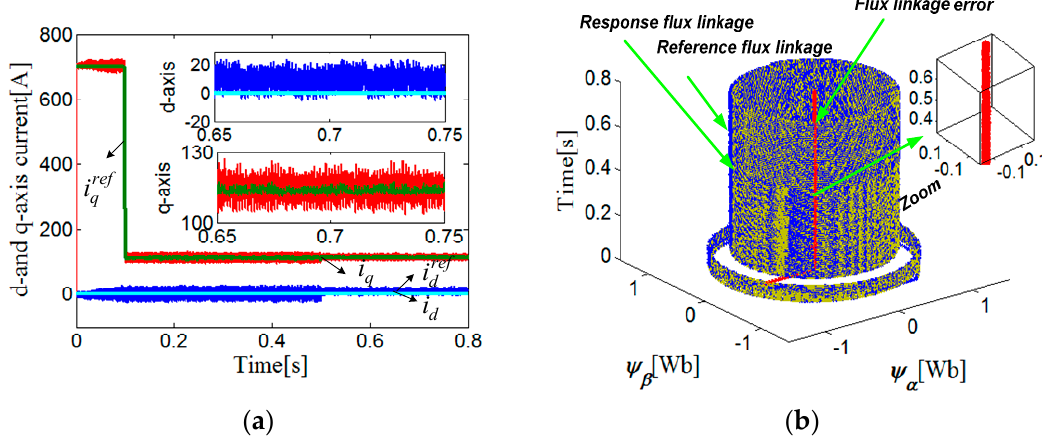
Figure 4. Simulation results of the conventional predictive current control (PCC) method under inductance parameter perturbation. ( a ) d ‐ and q ‐ axis current responses and references; ( b ) three ‐ dimension rotor flux trajectories.